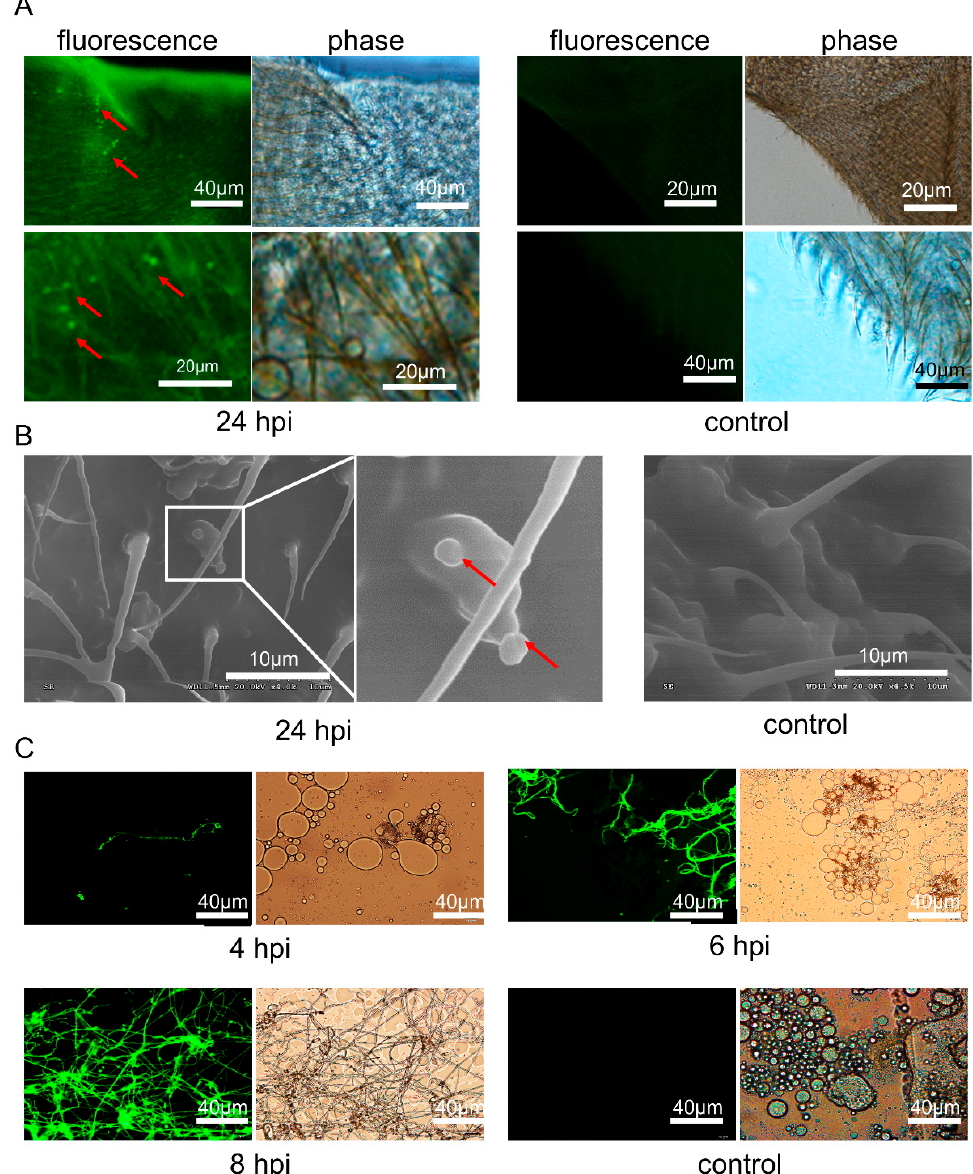
Figure 3. Invasion process of C. farinosa via the body surface. ( A ) Fluorescent microscopic observation of larval epidermis after 24 h of body surface infection; red arrows indicate the C. farinosa spores. ( B ) Scanning electron microscopy of the epidermis of larvae 24 h post-infection via the body surface; red arrows indicate the C. farinosa spores adhering to the epidermis and bristles. ( C ) Ob- servation of host hemolymph at different time points after body surface infection; green fluorescent signals indicate the transgenic C. farinosa . dpi: days post-infection; hpi: hour post-infection; control: untreated